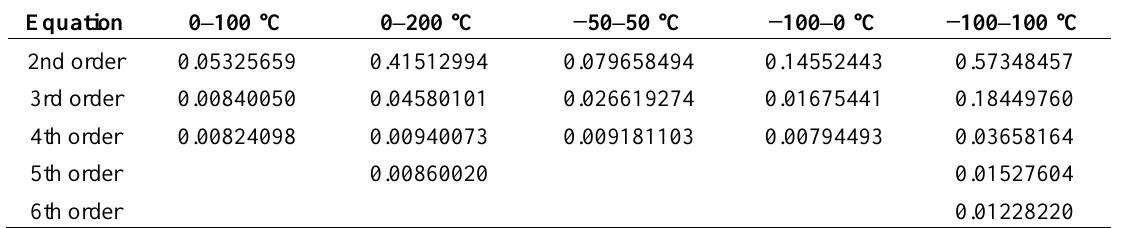
Table 3. Measurement precision of polynomial equations for T-type thermocouples by temperature